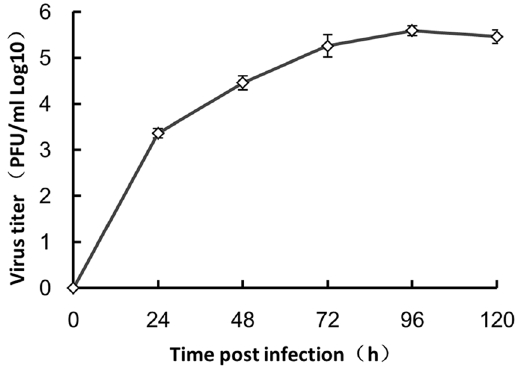
Figure 5. Accumulation of RRPs in the culture fluid of RRPs infected BWNV-CEM cells analysed by an infectivity assay. The titres are expressed as the total number of RRPs per mL supernatant of infected BWNV- CME